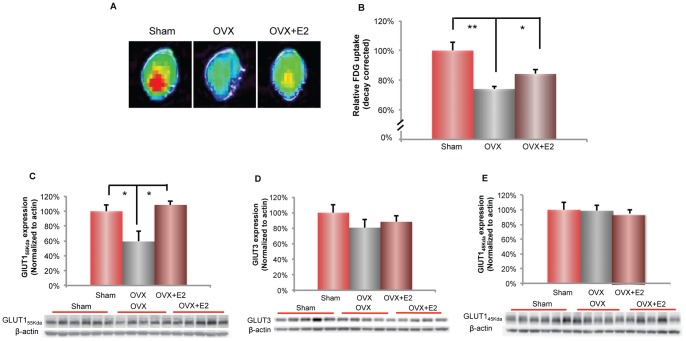
Ovariectomy (OVX) induced decline in brain glucose uptake and BBB GLUT155 Kda expression: prevention by 17β-estradiol.A. Representative FDG-microPET images showed a decline in brain glucose uptake in OVX condition, which was partially prevented by E2 treatment (50 µg/kg, SC). (Red and yellow indicate higher values; green and blue indicate lower values). B. Quantitative analysis of brain glucose uptake demonstrated a significant decrease in OVX condition (**, p<0.01, bars represent mean value±SEM, n = 5–7), which was partially prevented by E2 treatment (50 µg/kg, SC) (*, p<0.05; bars represent mean value±SEM, n = 5–6). C. OVX induced a significant decrease in protein expression of blood brain barrier glucose transporter 1 (GLUT155 Kda), which was prevented by E2 treatment (50 µg/kg, SC). (*, p<0.05, bars represent mean value ± SEM, n = 5–6). D. OVX induced a 20% decrease in protein expression of neuronal glucose transporter (GLUT3), which is partially prevented by E2 treatment (50 µg/kg, SC). E. No change in expressions of glial glucose transporter (GLUT145 Kda) between Sham-OVX, OVX and OVX+E2 groups.